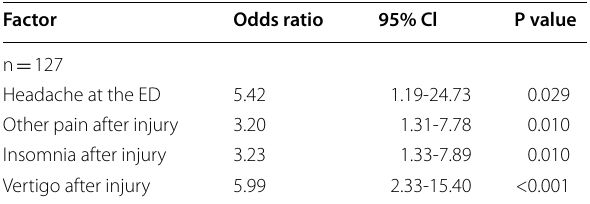
Table 2 Logistic regression analysis of the risk factors of